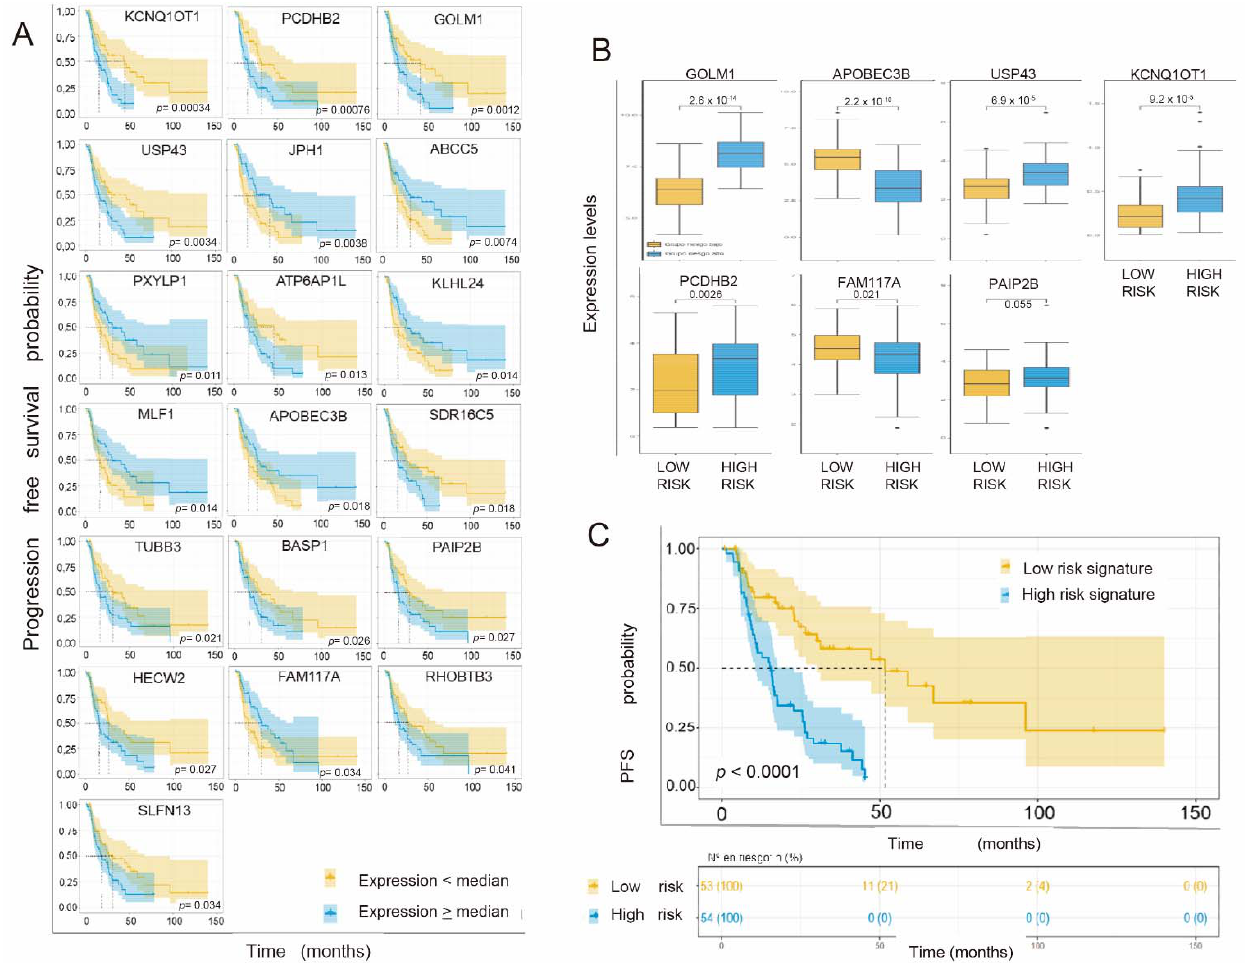
Figure 4. ( A ). Kaplan–Meier curves with the progression-free survival (PFS) probability of the 19 individual genes of interest ( p -value < 0.05) ordered by level of statistical significance. The probability of PFS (0–1) is represented on the ordinate axis and the PFS in months on the abscissa axis. Yellow represents patients whose expression level of the gene in question was lower than the median, and blue represents patients with expression levels equal to or greater than the median. ( B ). Box diagram showing the expression levels (logTPM) (normalized) on the ordinate axis of each gene as a function of each prognostic group (low or high risk). ( C ). Kaplan–Meier curves of the probability of PFS of the patients according to their signature by the established cutoff point, which corresponds to the median of the risk scores of each patient in the cohort, separating the latter into two groups (high or low risk, depending on whether their individual risk score is higher than/equal to or lower than the cutoff point, respectively). Likewise, the number of patients at risk in each group is represented according to the established time intervals. *, p < 0.05; **, p <